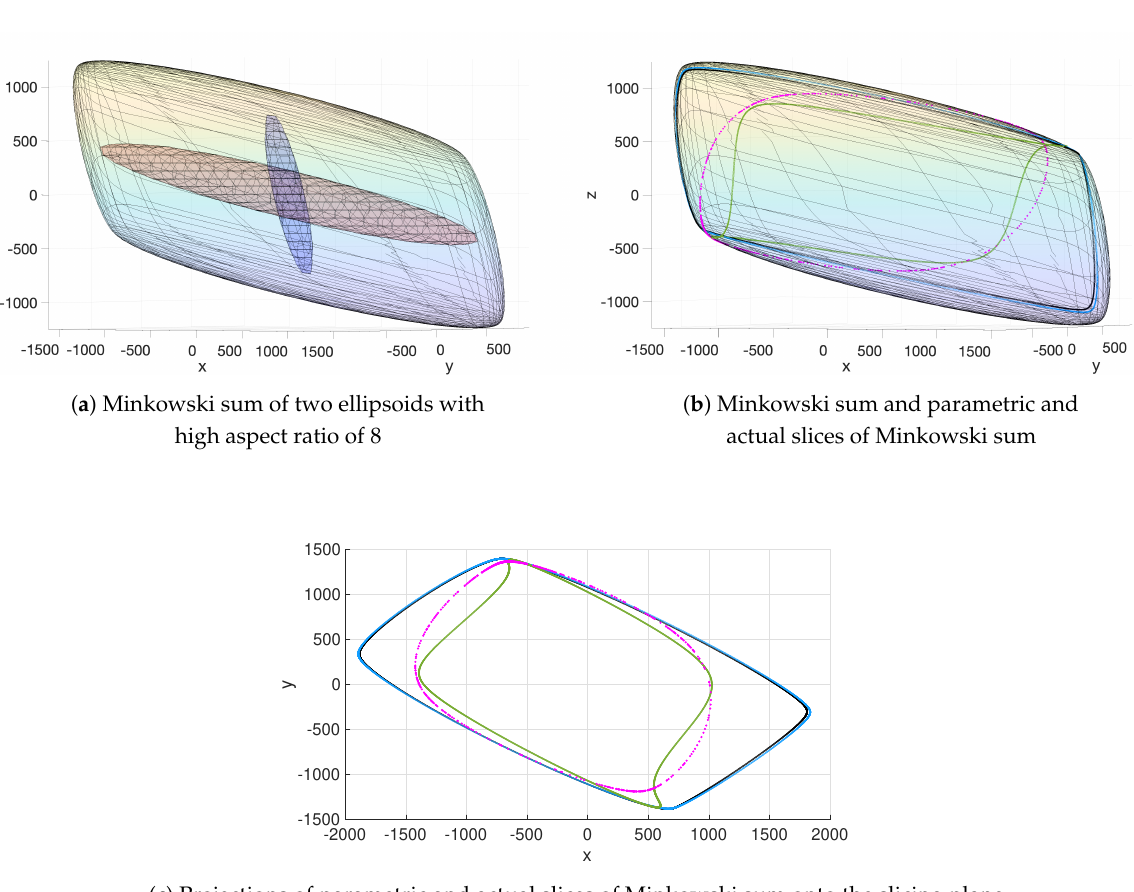
Figure 6. Parametric slices of Minkowski sum for a Minkowski sum of two ellipsoids with high aspect ratio of 8, sliced up by a similar plane to the sample in Figure 4a,b. The parametric slices are computed by: MVOE from minimization of (7) (black), John’s inner bound (12) (blue) and the second eigenvalue λ 2 ( A T A i ) in (16) (green). The actual slice of Minkowski sum is i